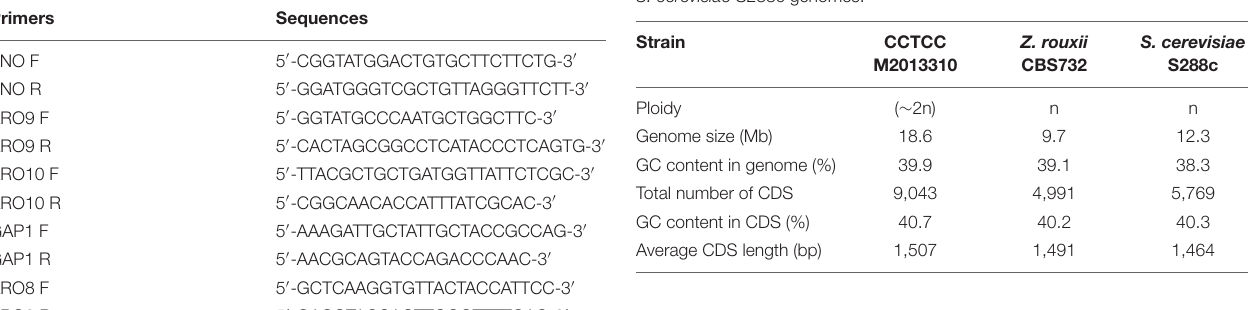
TABLE 2 | The primers used in this study.